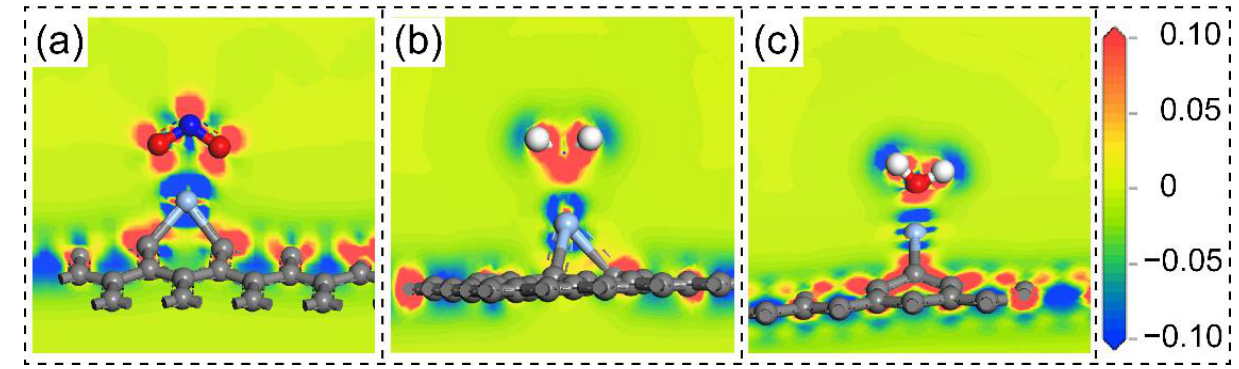
Figure 4. Difference charge densities of Ag–Gr adsorption with ( a ) NO 2 , ( b ) NH 3 , and ( c ) H 2 O.